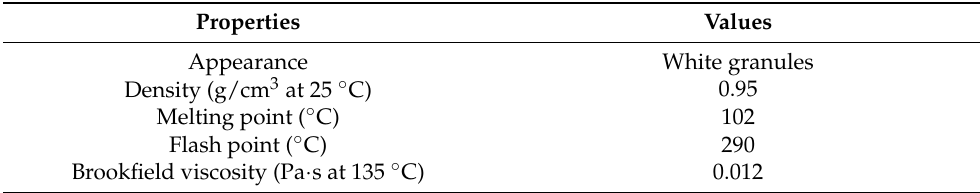
Table 2. Characteristics of warm-mixed asphalt